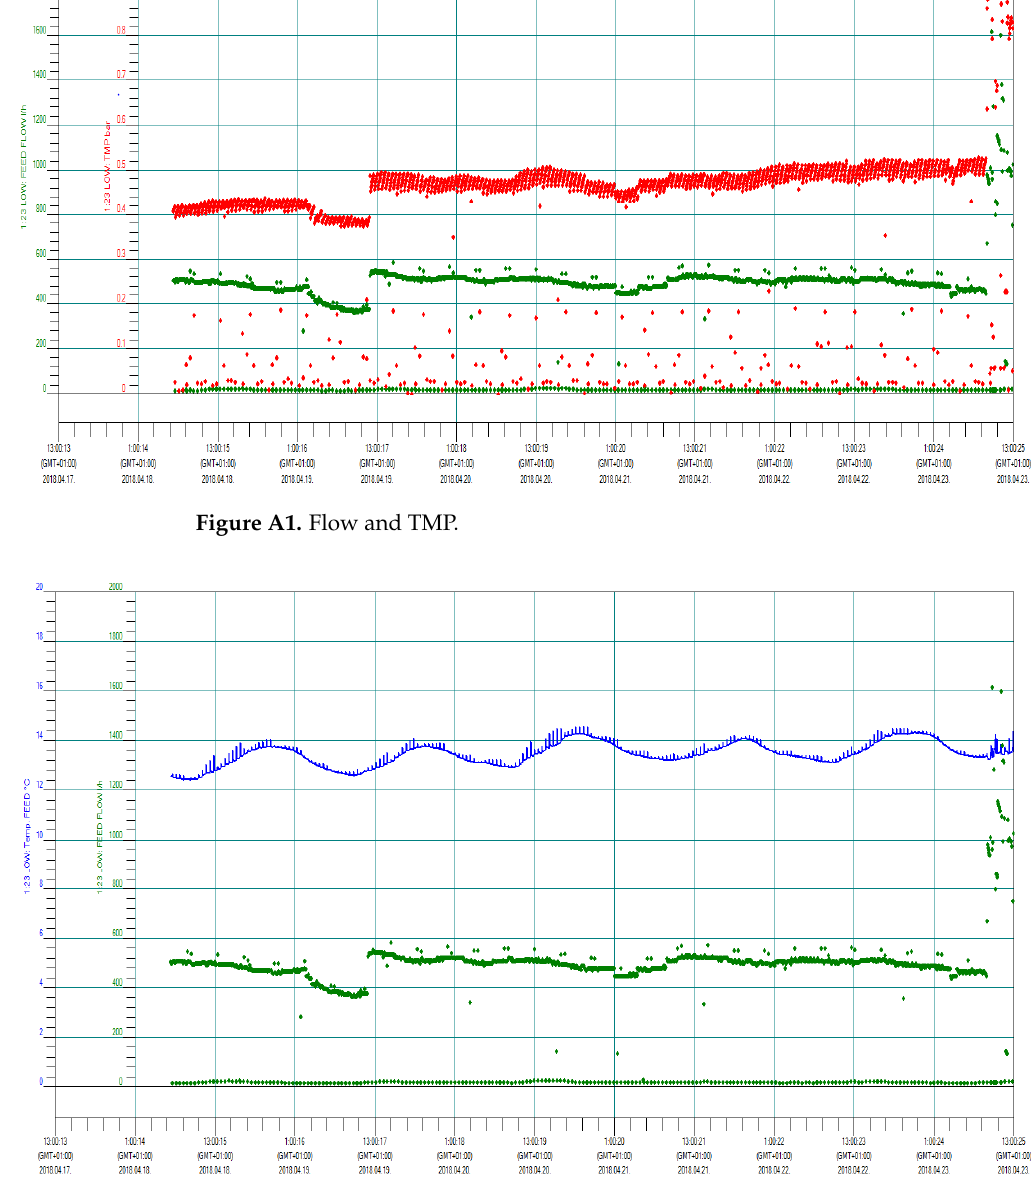
Figure A2. Flow and temperature.